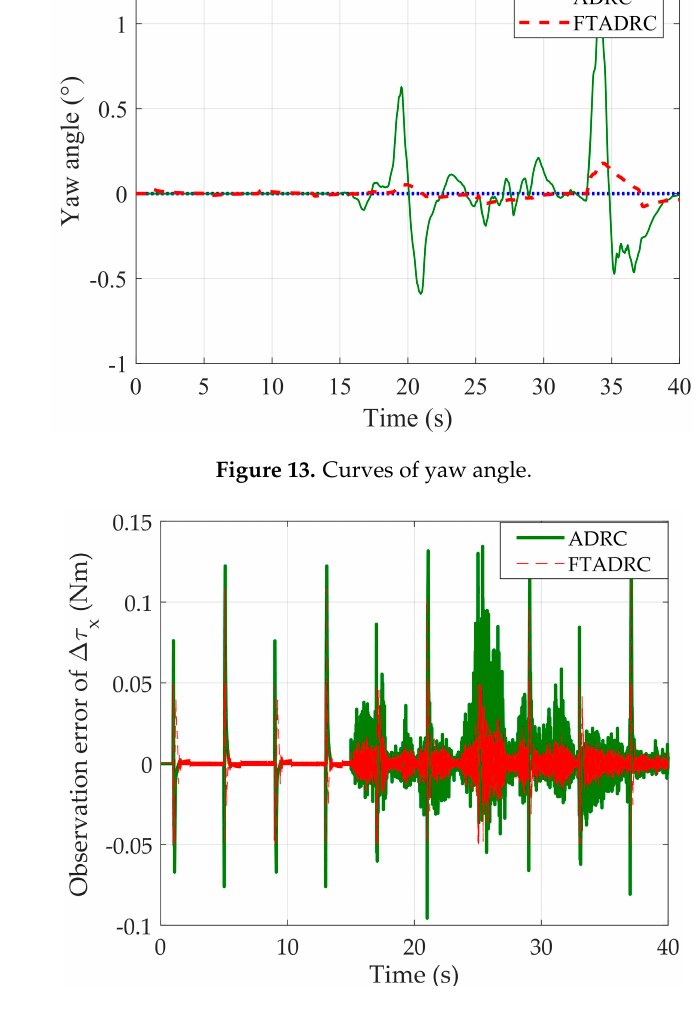
Figure 14. Curves of observation error for ∆ τ x .